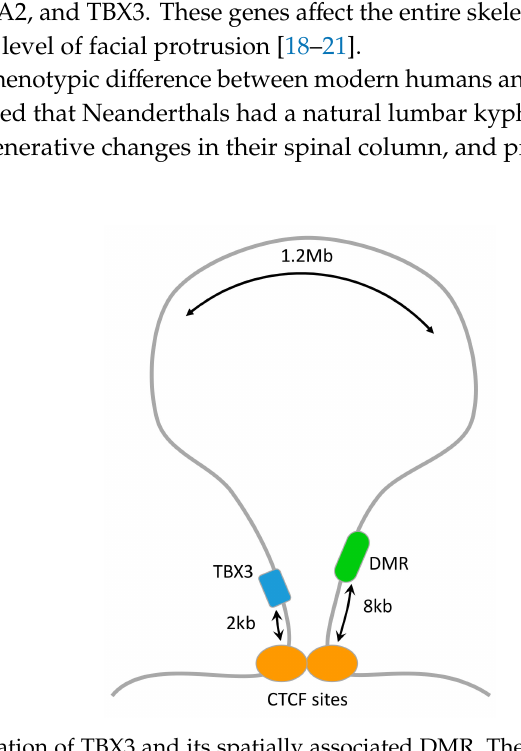
Figure 3. An illustration of TBX3 and its spatially associated DMR. The black arrows represent the distance between the DMR and a ChIA-PET validated CTCF binding site and TBX3 and a ChIA-PET validated CTCF binding site [23]. The linear distance between TBX3 and the DMR is 1.2